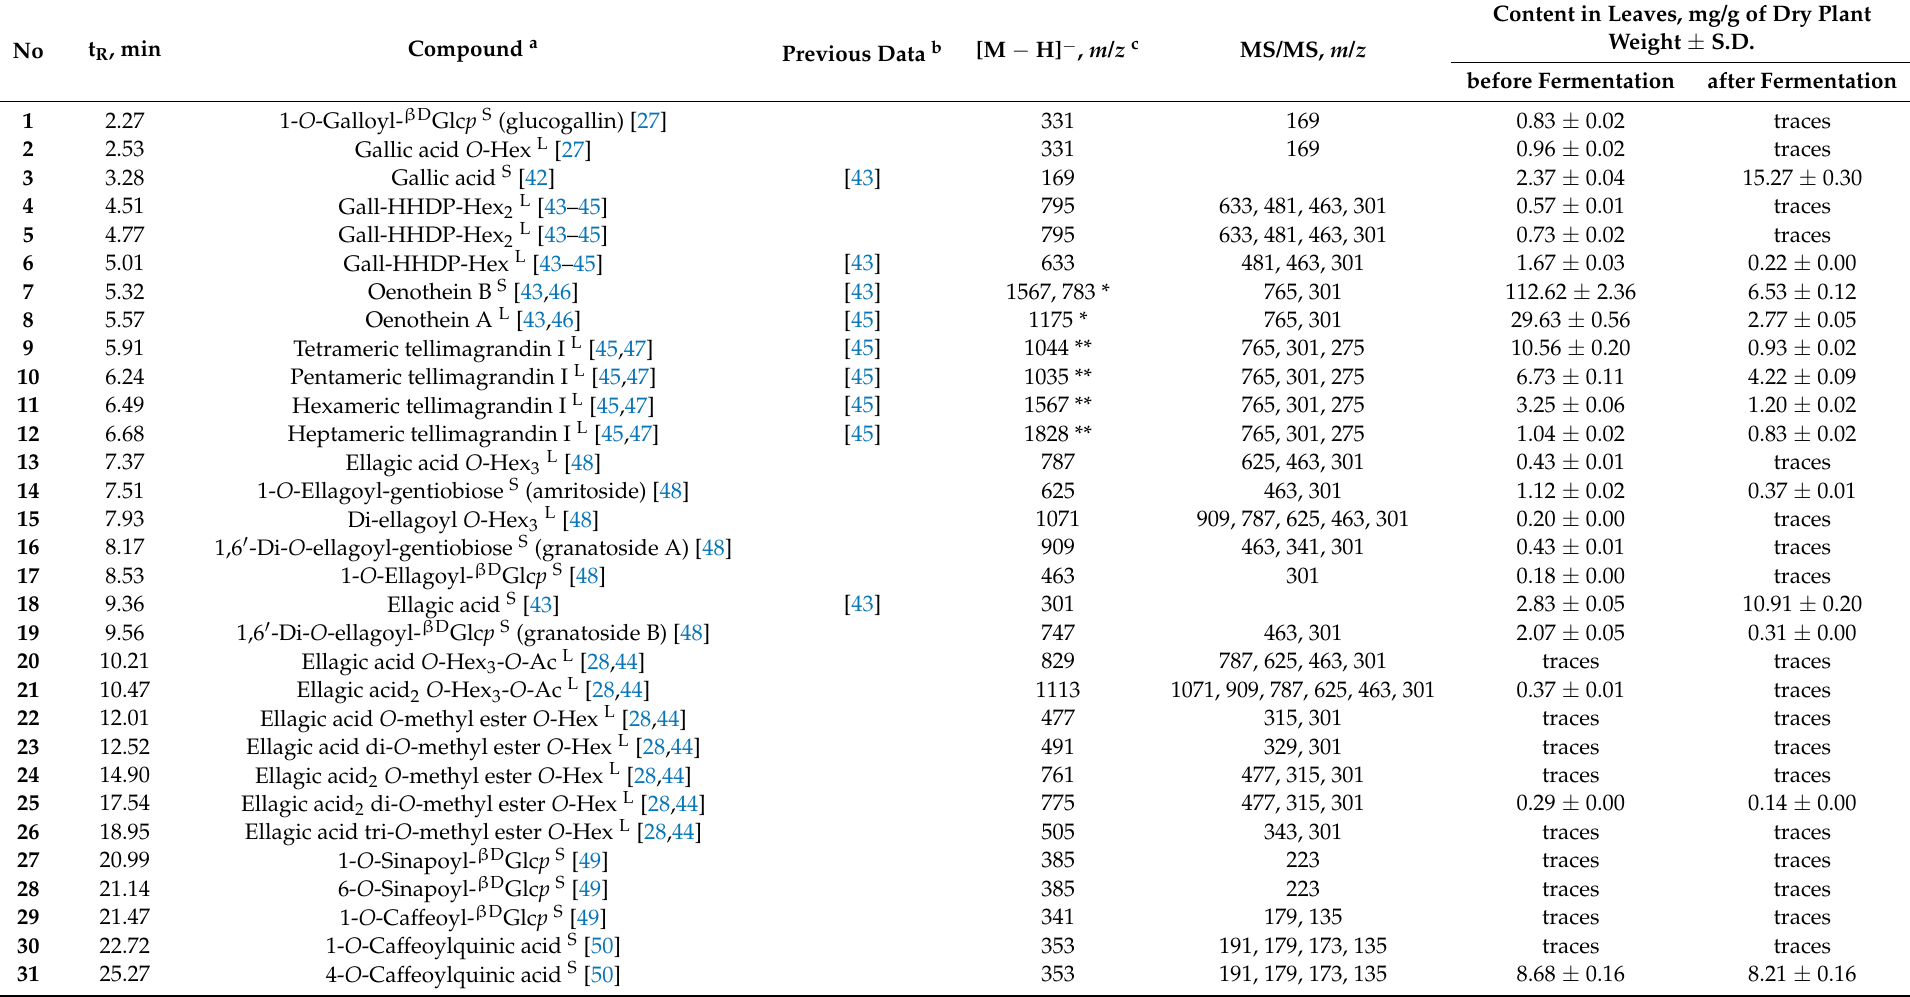
Table 2. Compounds 1 – 59 were found in E. angustifolium leaves before and after